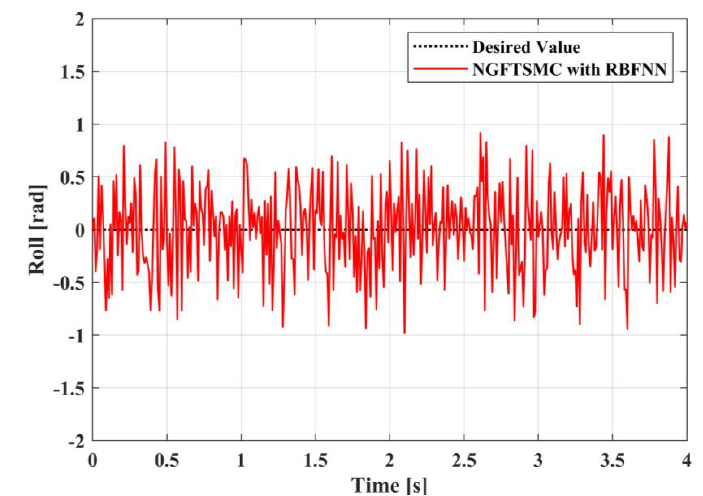
Figure 20. The experimental results in roll angel.